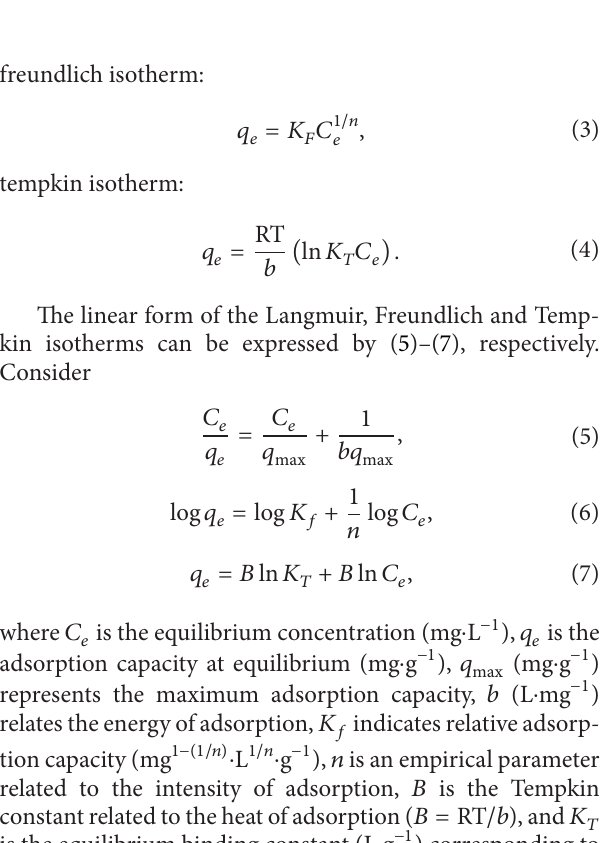
Figure 5: Langmuir (a), Freundlich (b), and Tempkin (c) adsorption isotherms for U(VI) adsorption by EIR (pH 4.5 and temperature 298 K).